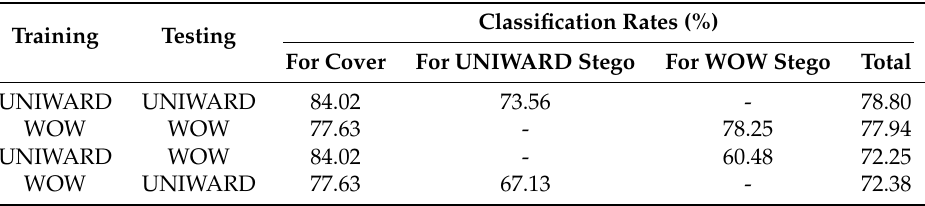
Table 1. Cross identification between WOW and UNIWARD ( bpp = 0.4).